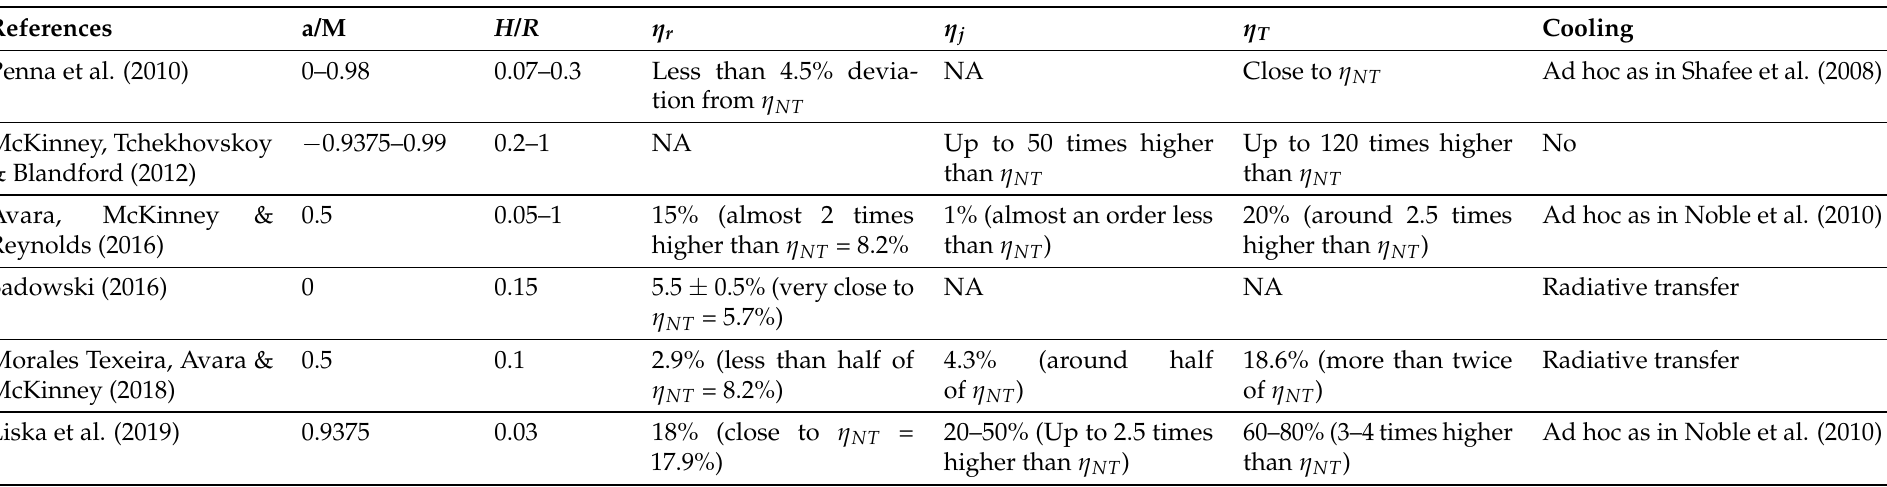
Table 1. Results from some representative general relativistic magnetohydrodynamic (GRMHD) simulation works showing black hole spin (a/M), scale height ( H / R ), disk